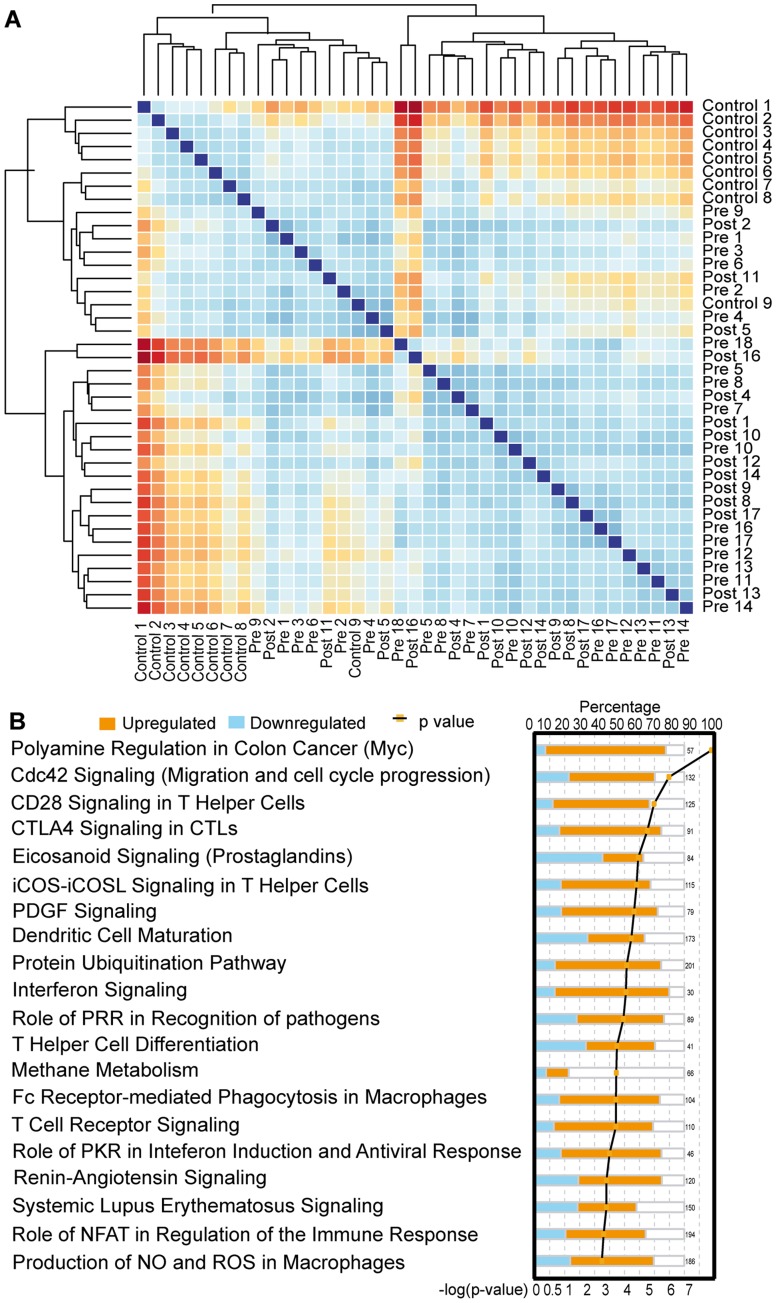
Comparison of gene expression of PBLs of mRCC patients and healthy controls following normalization of microarray expression data.
 A:Microarray Data: The gene-expression profiles of PBLs from all patients (pre- and post-treatment) and from healthy donors (control) were compared by unsupervised hierarchical clustering using Manhattan distance after mean centering for definition of hierarchy. Shown is a correlative or adjacency matrix. A gene expression profile for each chip is calculated and compared with those of all other chips. The chips with similar gene expression profile cluster together. Red denotes a large distance between gene expression of arrays; dark blue means no distance (diagonal line). The largest distance can be detected for the comparison Control1 versus mRCC patient 16 Post. B: Ingenuity Pathway Analysis (IPA): A list of highly altered pathways after comparing gene expression between healthy controls and patients pre-treatment. Percentage of genes (of all known involved genes) altered in our dataset is shown on the top axis. Orange bars indicate up-regulation of genes and blue bars indicate down-regulation of genes. The bottom axis shows the log p-value that indicates how significantly the identified genes are associated to the pathway. IPA identified pathways reflecting an overall activation of the immune system as well as an alteration of T- and B-cell signaling pathways.